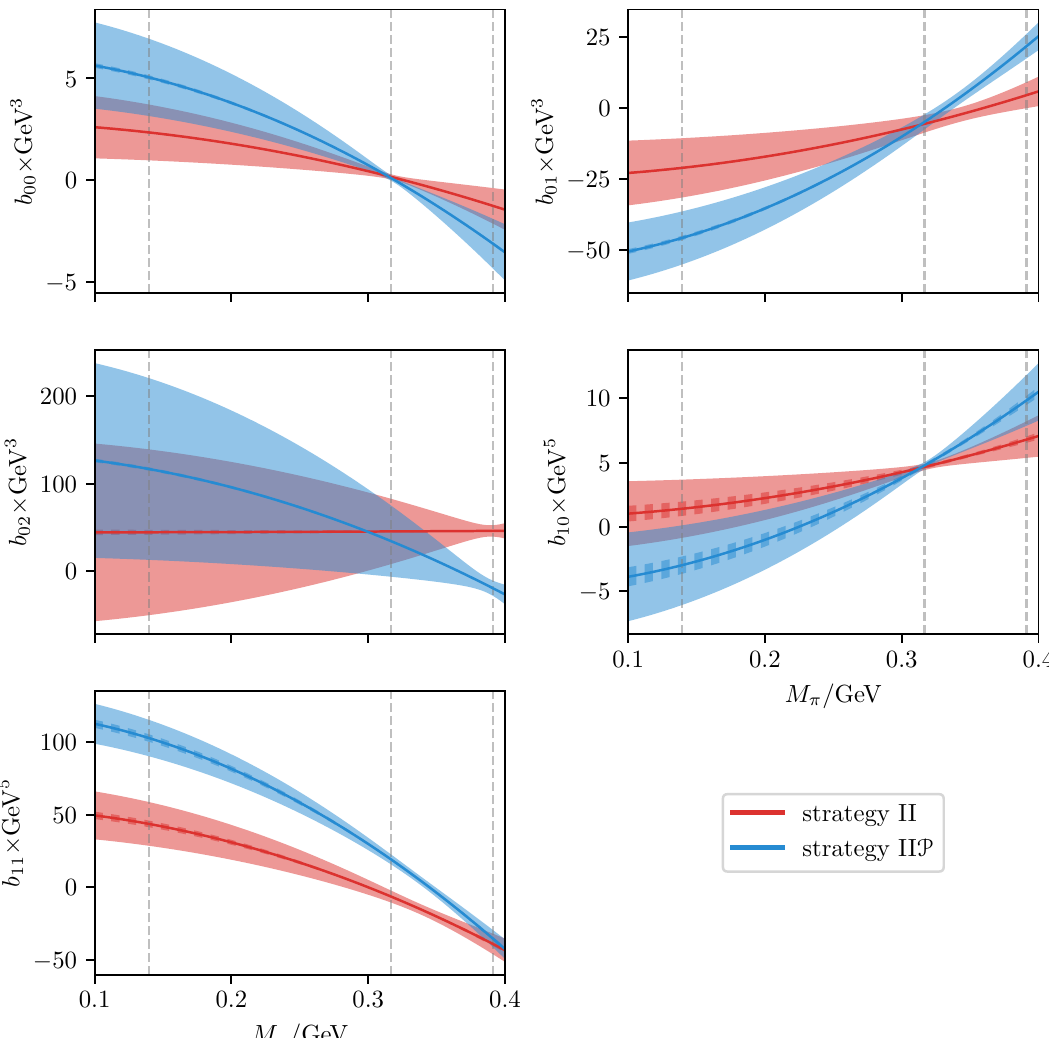
Figure 4. The pion-mass dependence of the fit parameters for two different fit strategies. The dashed gray lines mark the physical pion mass and the ones of the two lattice data sets, the dashed error bands correspond to the error of the lattice spacings, while the filled ones are associated with the statistical